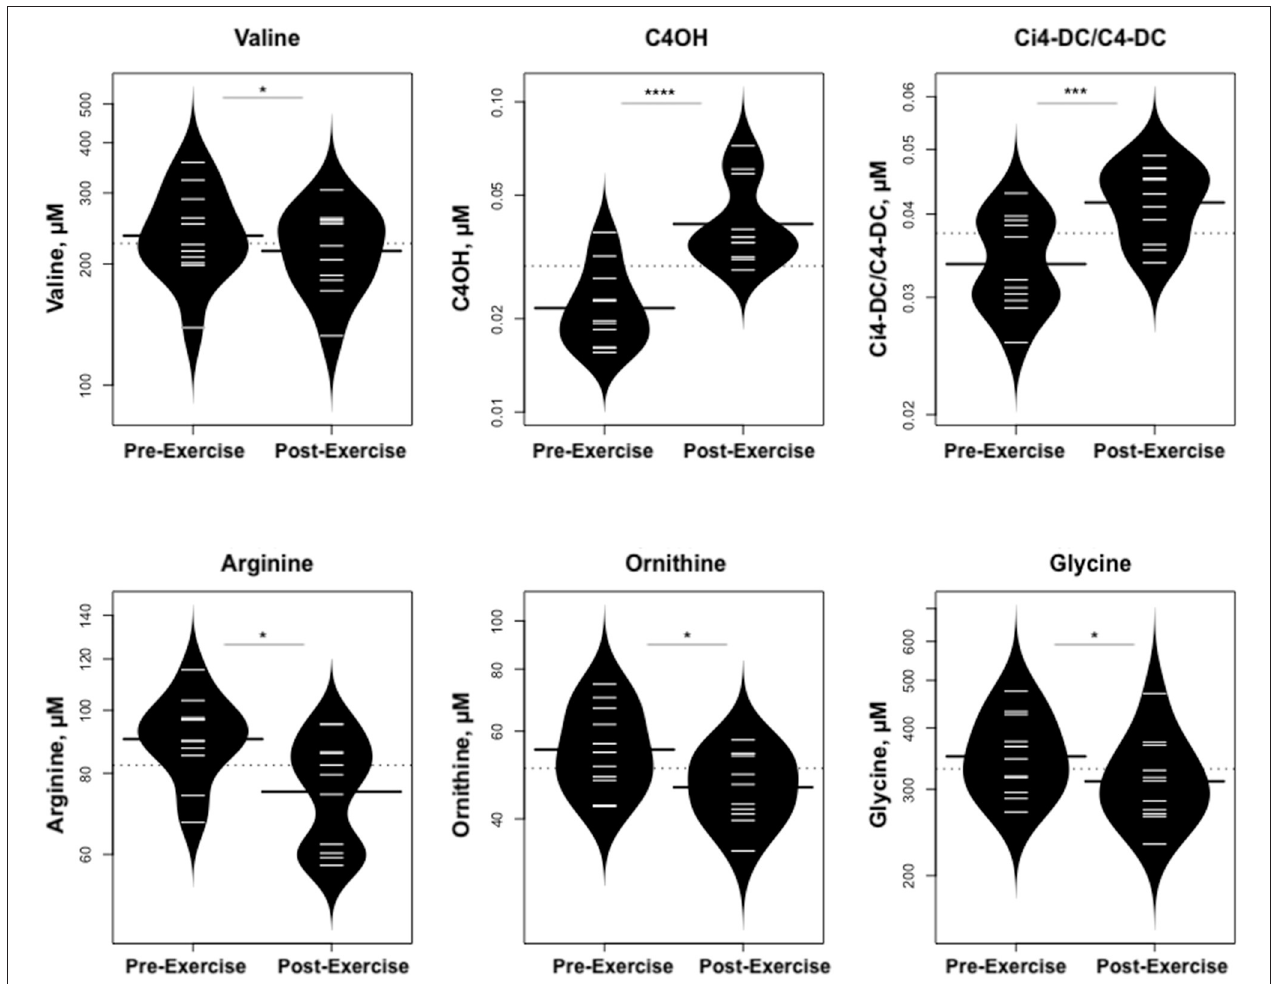
FIGURE 4 | Changes in metabolites related to BCAA catabolism and urea cycle. * p < 0.01, *** p < 0.0001, **** p <